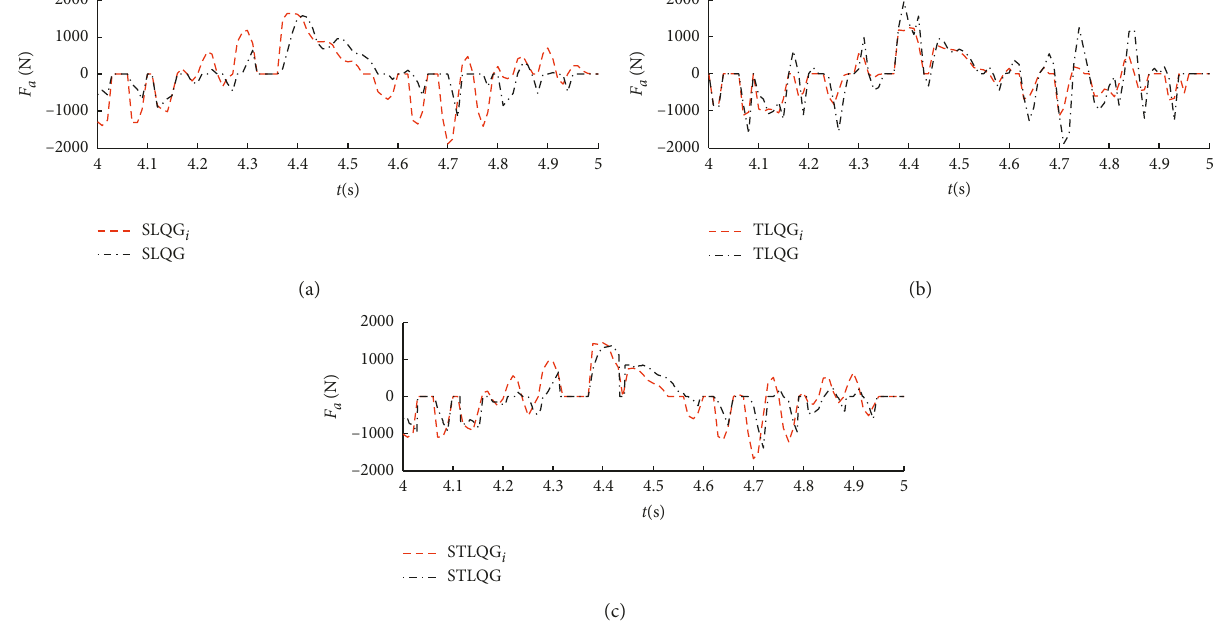
Figure 6: F a - t curves under 20ms time delay (partial